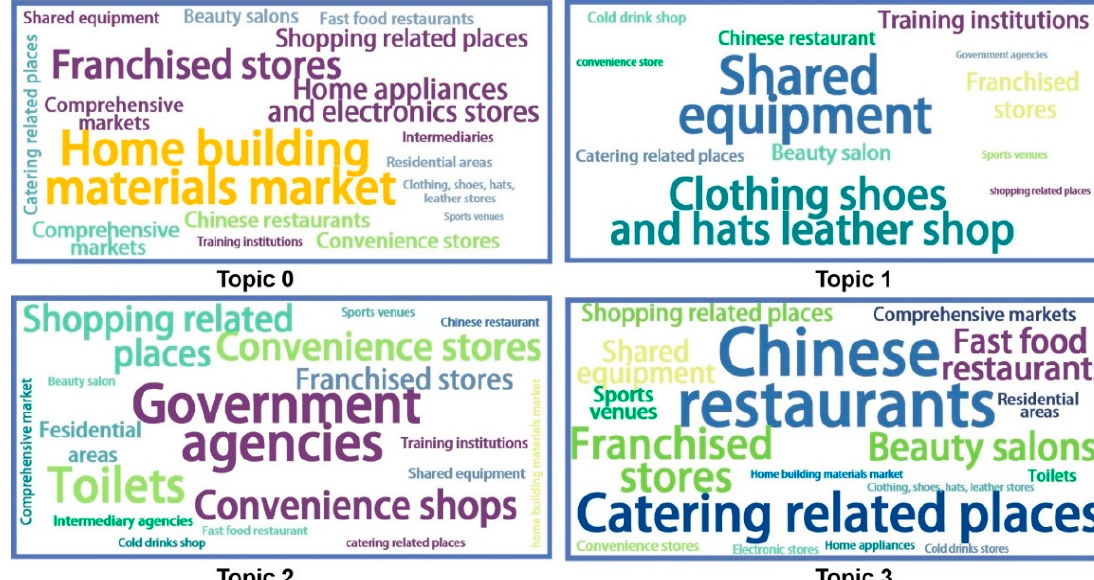
Figure 3. LDA results of LDA topic modeling.